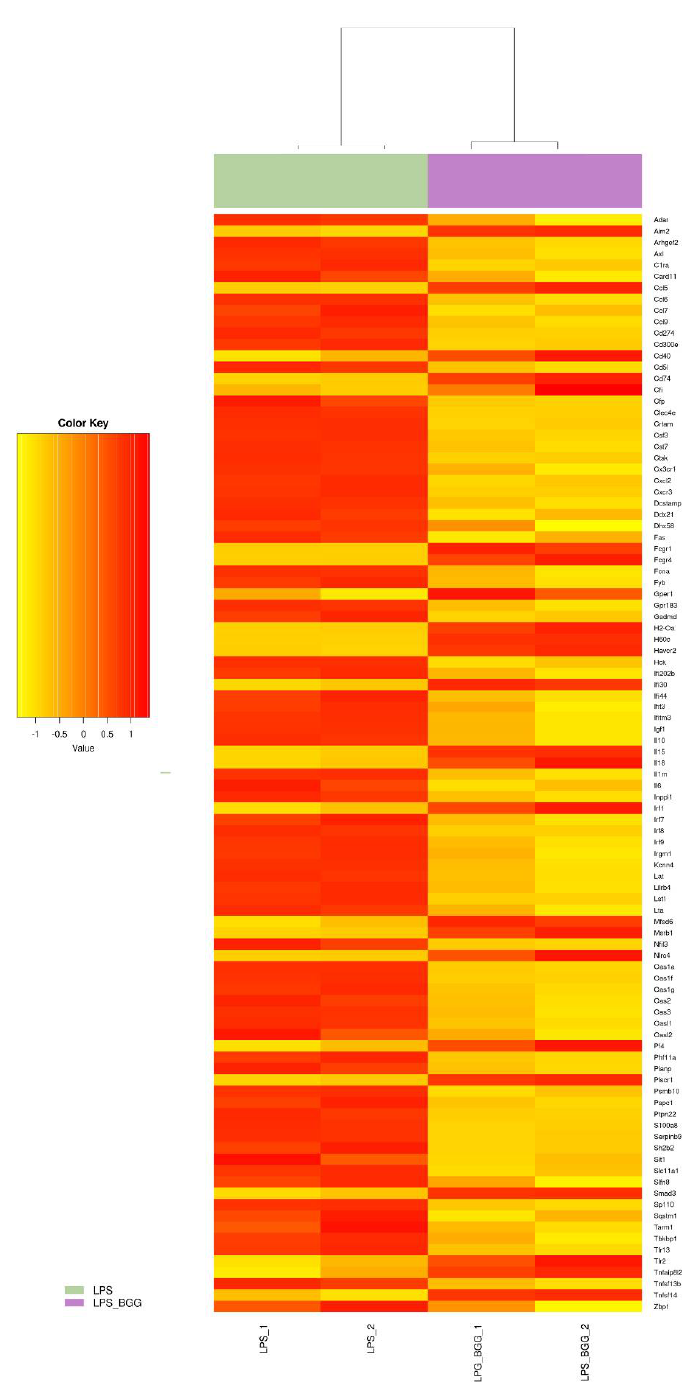
Figure 7. Heatmap represents the genes involved in the immune system pathway from microarray gene expression. MAPK pathways were included in the analysis of the KEGG database. DAVID repre-